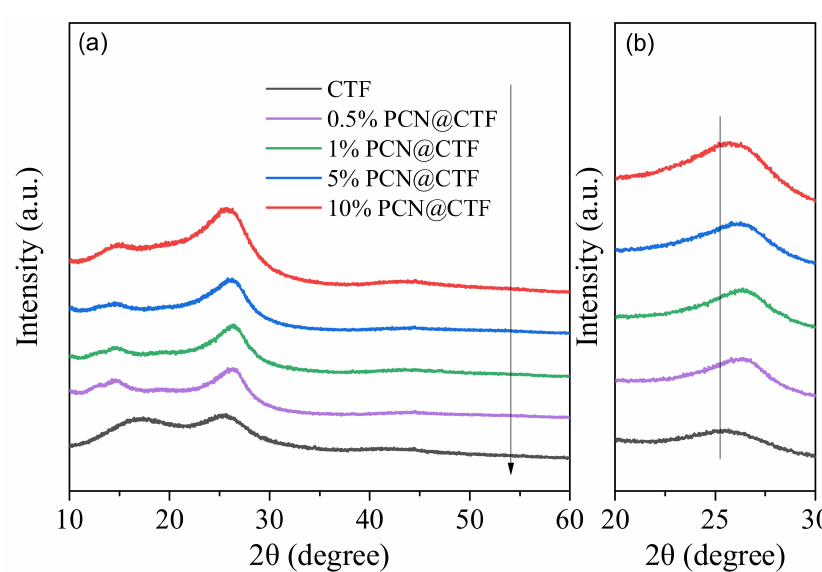
Figure 1. TEM images of ( a ) CTF and ( b ) 1%PCN@CTF.